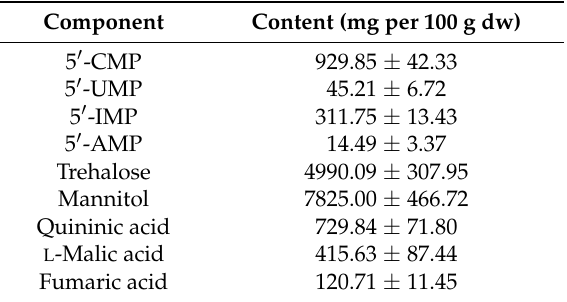
Table 4. Flavor 5 (cid:48) -nucleotides, free sugars and organic acids composition of wild L. deliciosus